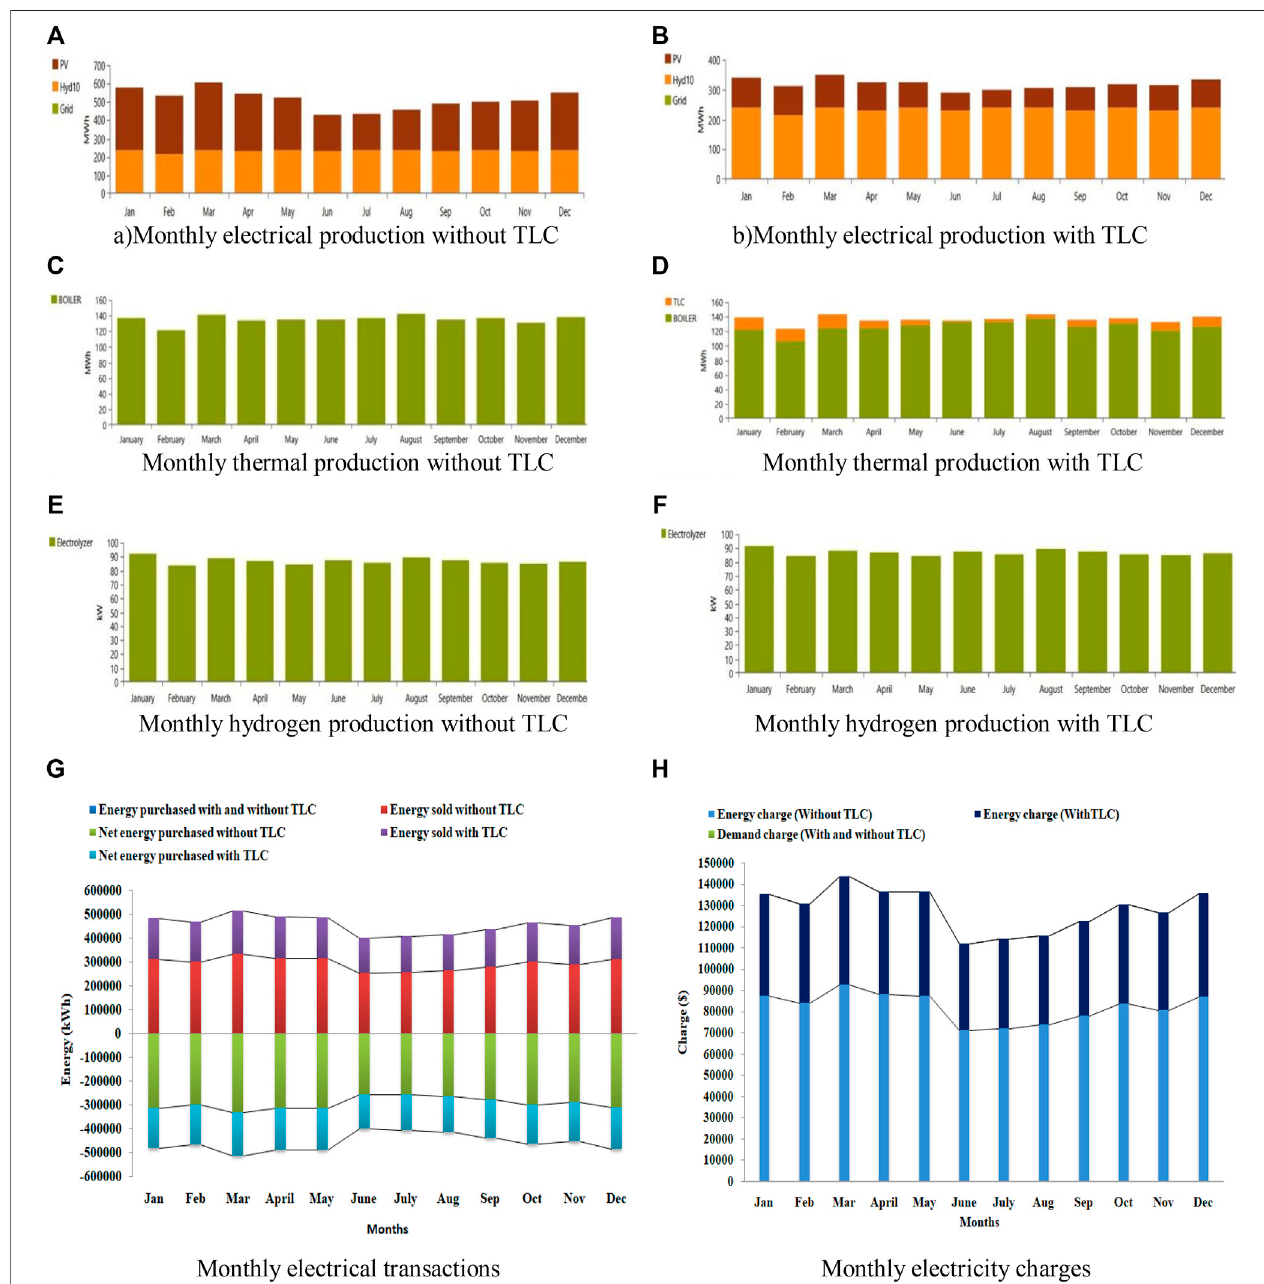
FIGURE13| Monthlyenergyproductions,transactions,andcharges. (A) MonthlyelectricalproductionwithoutTLC. (B) MonthlyelectricalproductionwithTLC. (C) MonthlythermalproductionwithoutTLC. (D) MonthlythermalproductionwithTLC. (E) MonthlyhydrogenproductionwithoutTLC. (F) Monthlyhydrogenproductionwith TLC. (G) Monthly electrical transactions. (H) Monthly electricity